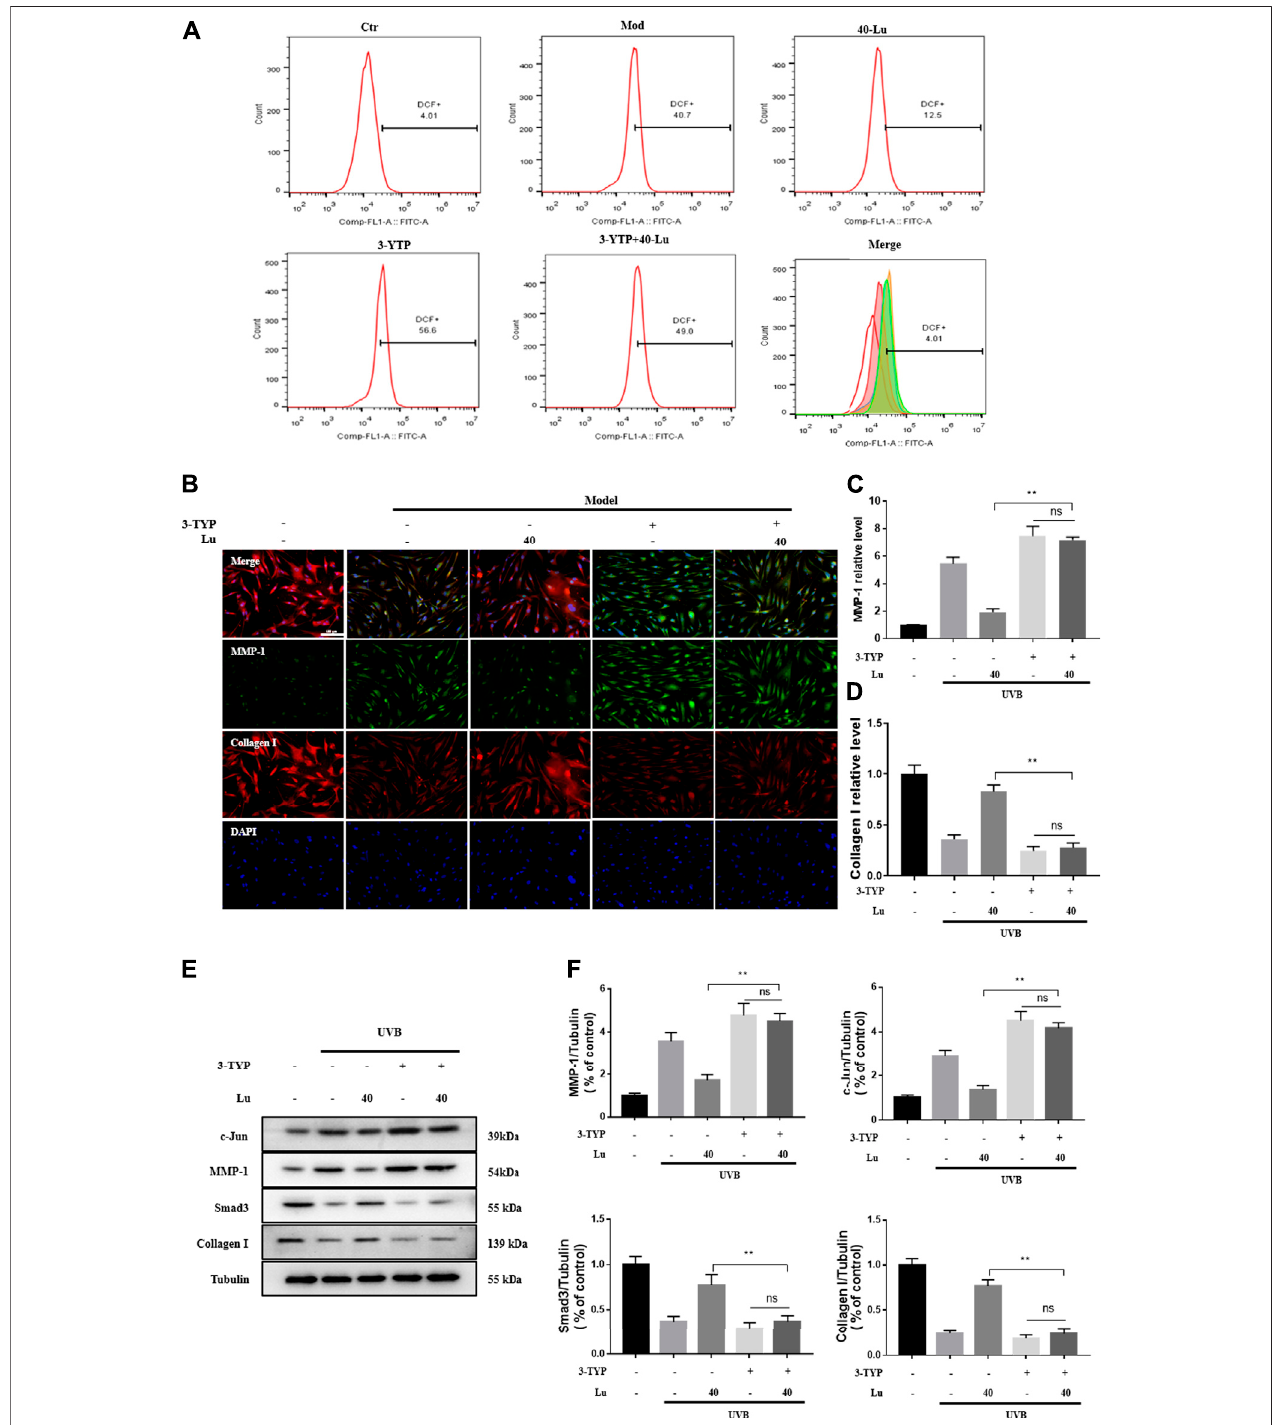
FIGURE 7 | 3-TPY counteracts Luteolin ’ s protection of cells from UVB-induced damage. (A) 3-TPY inhibited the inhibitory effect of luteolin on intracellular ROS accumulation. (B) Representative image of immuno fl uorescence staining for MMP-1 and Collagen I. (C) 3-TPY inhibited the inhibitory effect of luteolin on intracellular MMP-1 expression. (D) 3-TPY inhibited the promotion of luteolin on intracellular Collagen I expression. (E) Representative immunoblots of c-Jun, MMP-1, Smad3 and Collagen I protein expressions in cell. (F) Optical density histograms of c-Jun/Tubulin, MMP-1/Tubulin, MMP-1/Tubulin, Smad3/Tubulin and Collagen I/Tubulin. * indicates a signi fi cant difference between the two groups (* p < 0.05; ** p < 0.01).